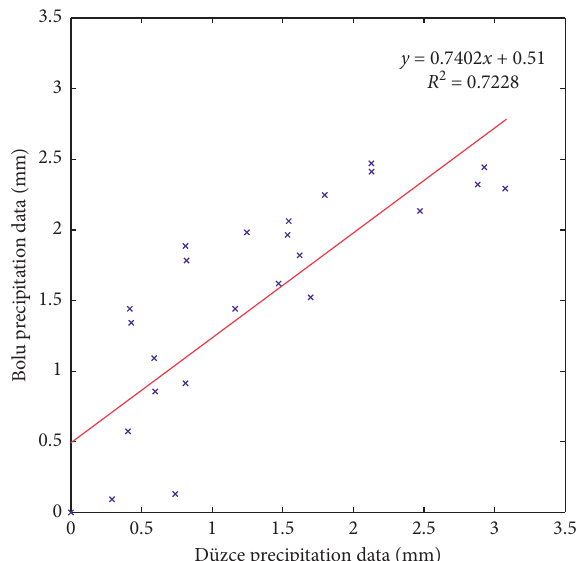
Figure 3: The linear fit among monthly rainfall data of D¨uzce and Bolu between January 2008 and November 2009.